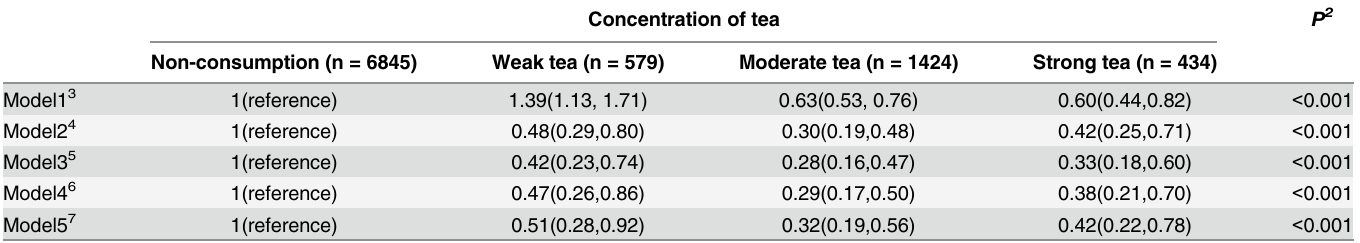
Table 5. Logistic regression models fitting results of the association between tea concentration and cognitive impairment 1